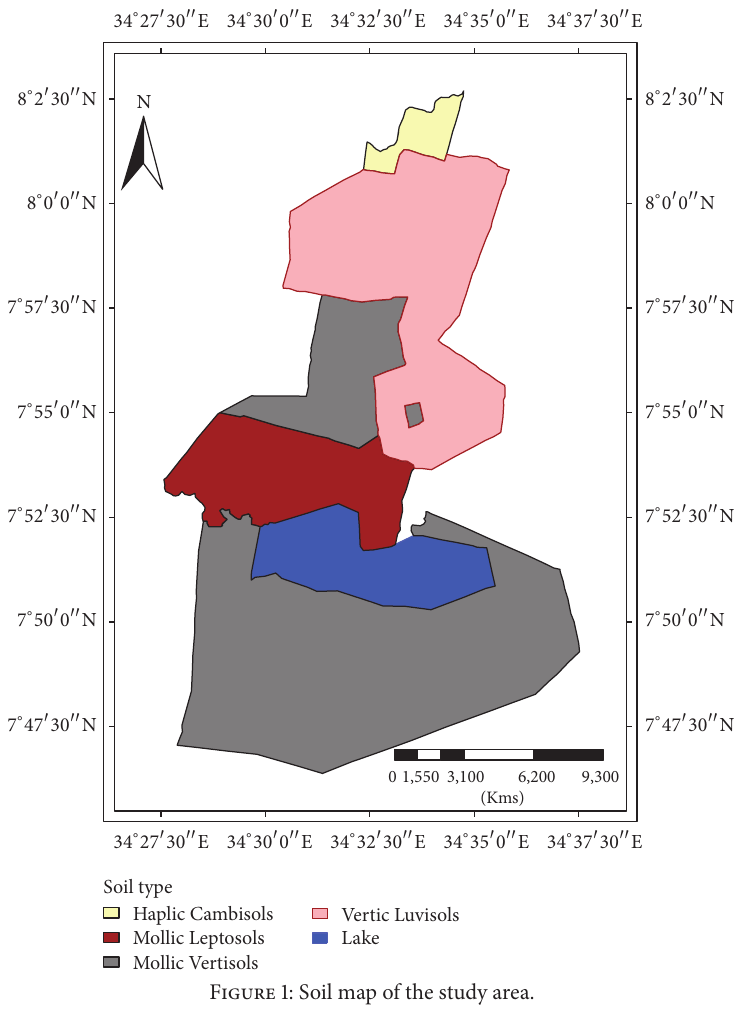
Figure 1: Soil map of the study area. Table 11: Diagnostic horizons, properties, quantifiers, and soil types of Abobo area according to WRB. Diagnostic horizon Pedon Diagnostic